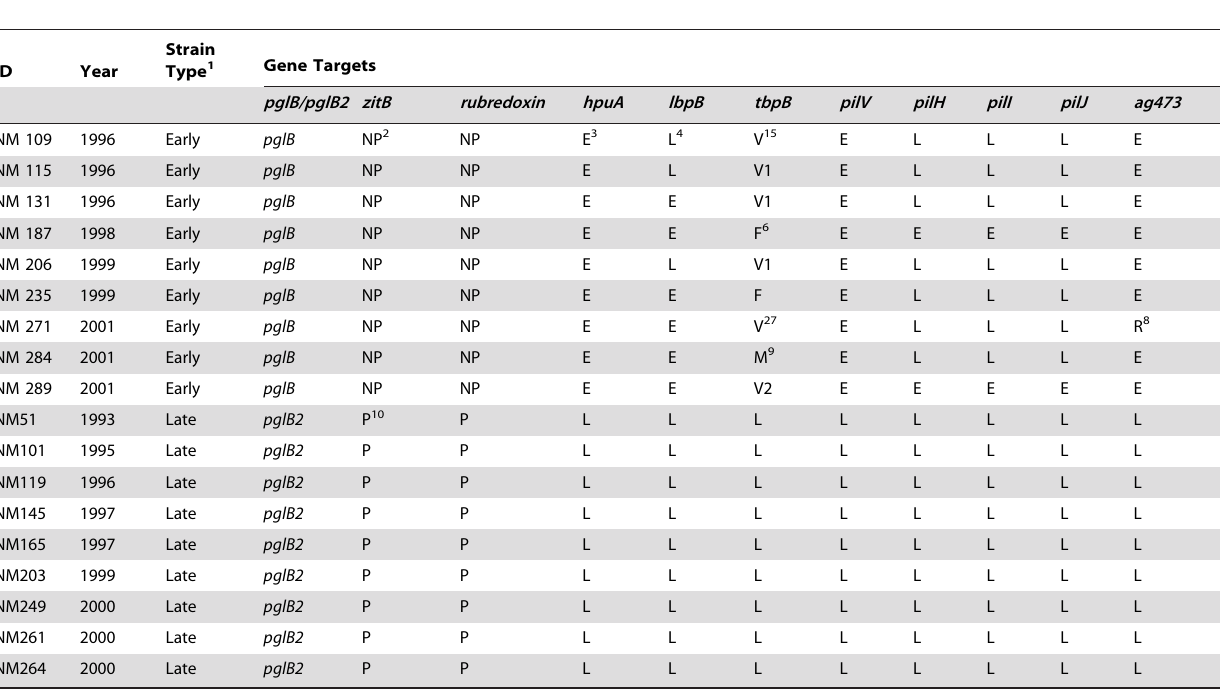
Table 5. Early and late strain type population isolates, year of isolation, and results of PCR and Sanger sequencing of target